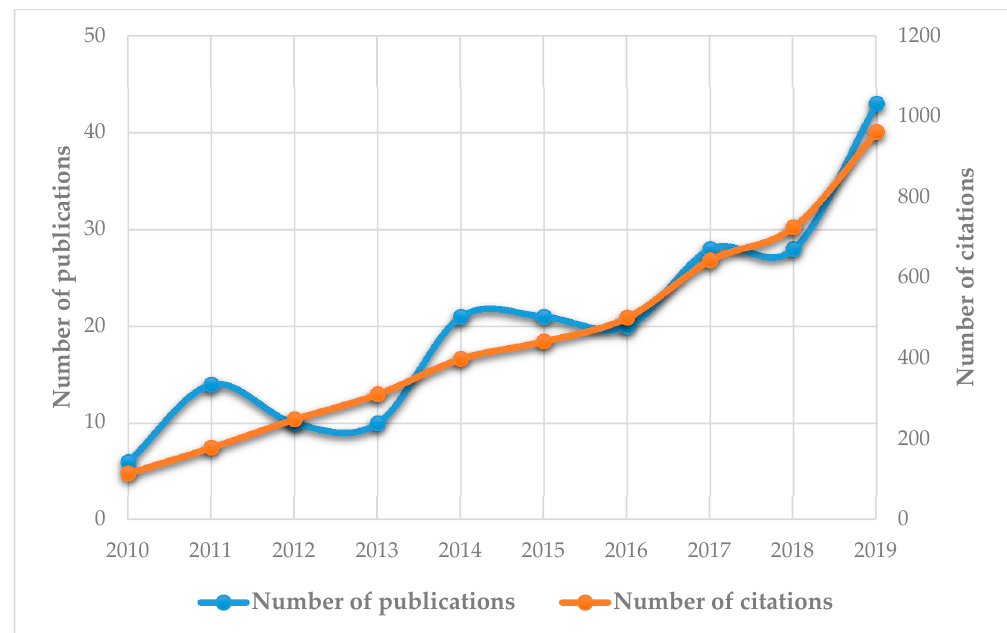
Figure 1. Number of publications (blue line) and citations (red line). Data were obtained using Scopus (August 2020). Research criteria: TITLE-ABS-KEY (thermal treatment) OR (non-thermal treatment) OR (ohmic heating) OR (microwave heating) OR (radio frequency heating) OR (infrared heating) OR (pulsed electric field) OR (modified atmosphere packaging) OR (cold atmospheric plasma) OR (ultrasound) OR (high pressure processing) AND (spectroscopy) AND (fish) OR (meat) OR (muscle food).